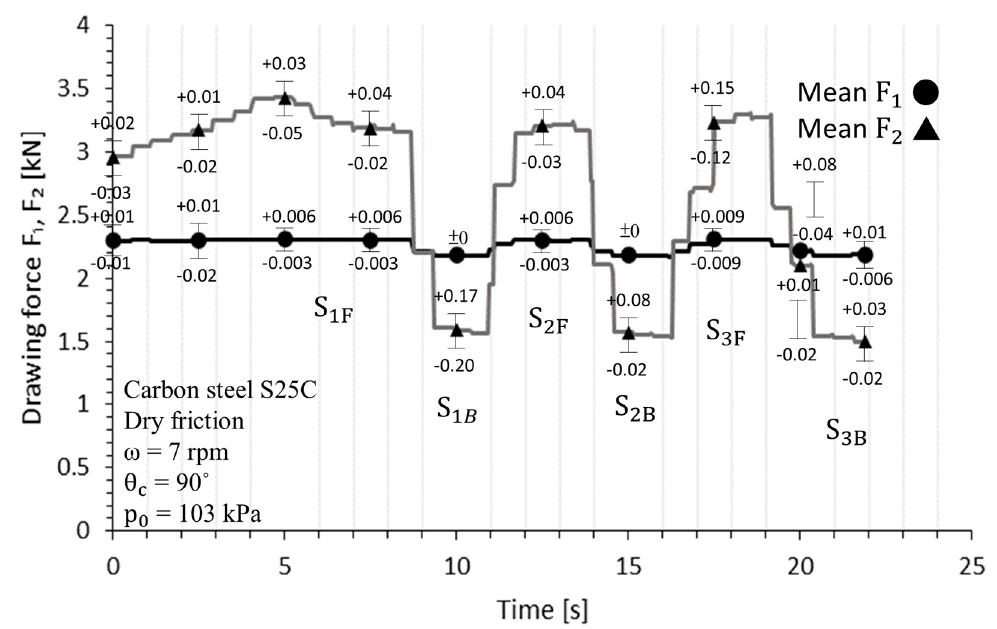
Figure 4. Drawing force variations in friction tests.